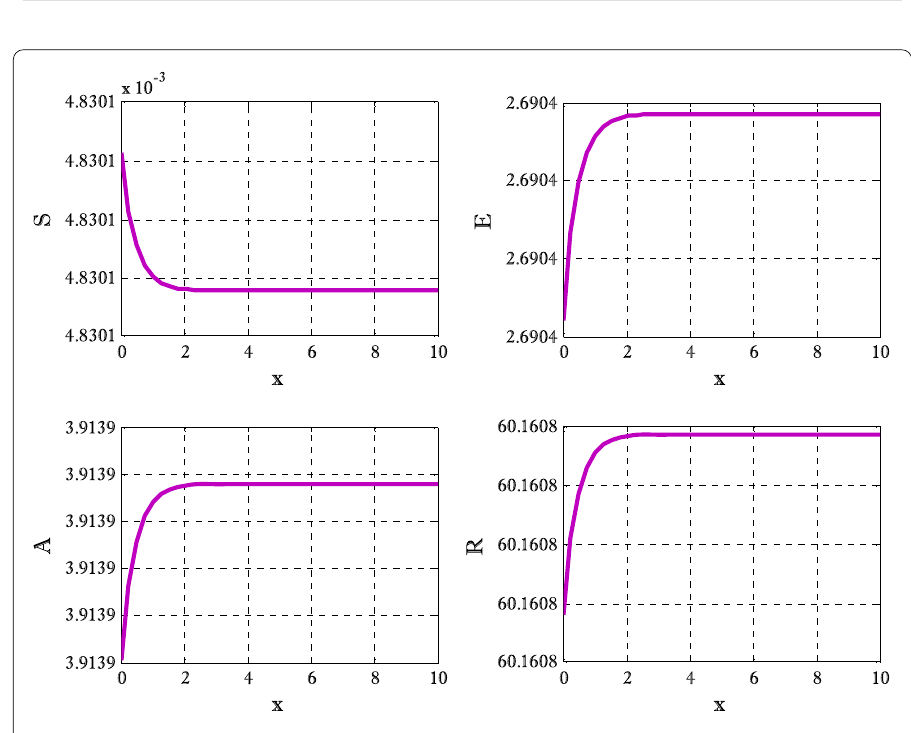
Figure 14 Solution obtained by proposed scheme t = 10, N x = 40, N t = 190, α = 0.1, β = 0.3, γ = 0.4, σ = 0.1, μ = 0.4, d 1 = d 2 = d 3 = d 3 = d 5 =